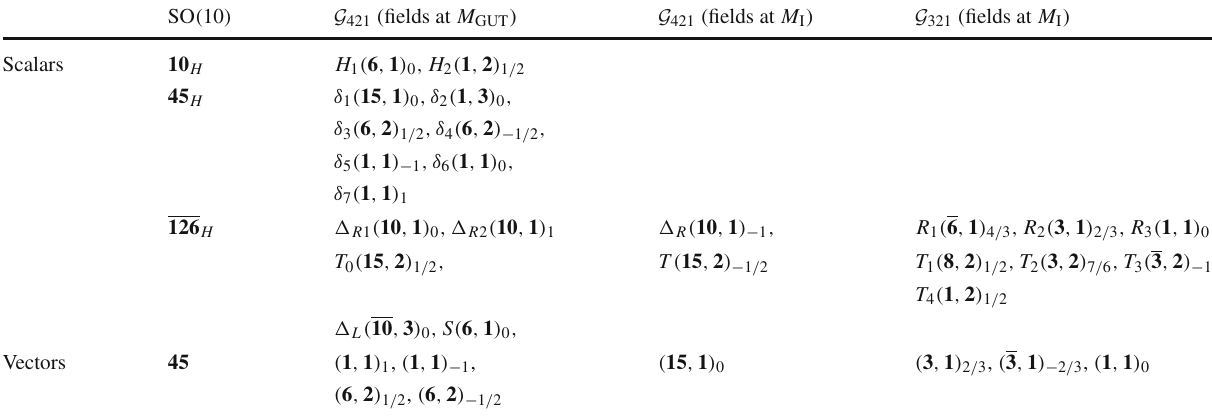
Table 6 Scalar and vector fields that have masses around M GUT and M I in the G 421 model SO ( 10 )